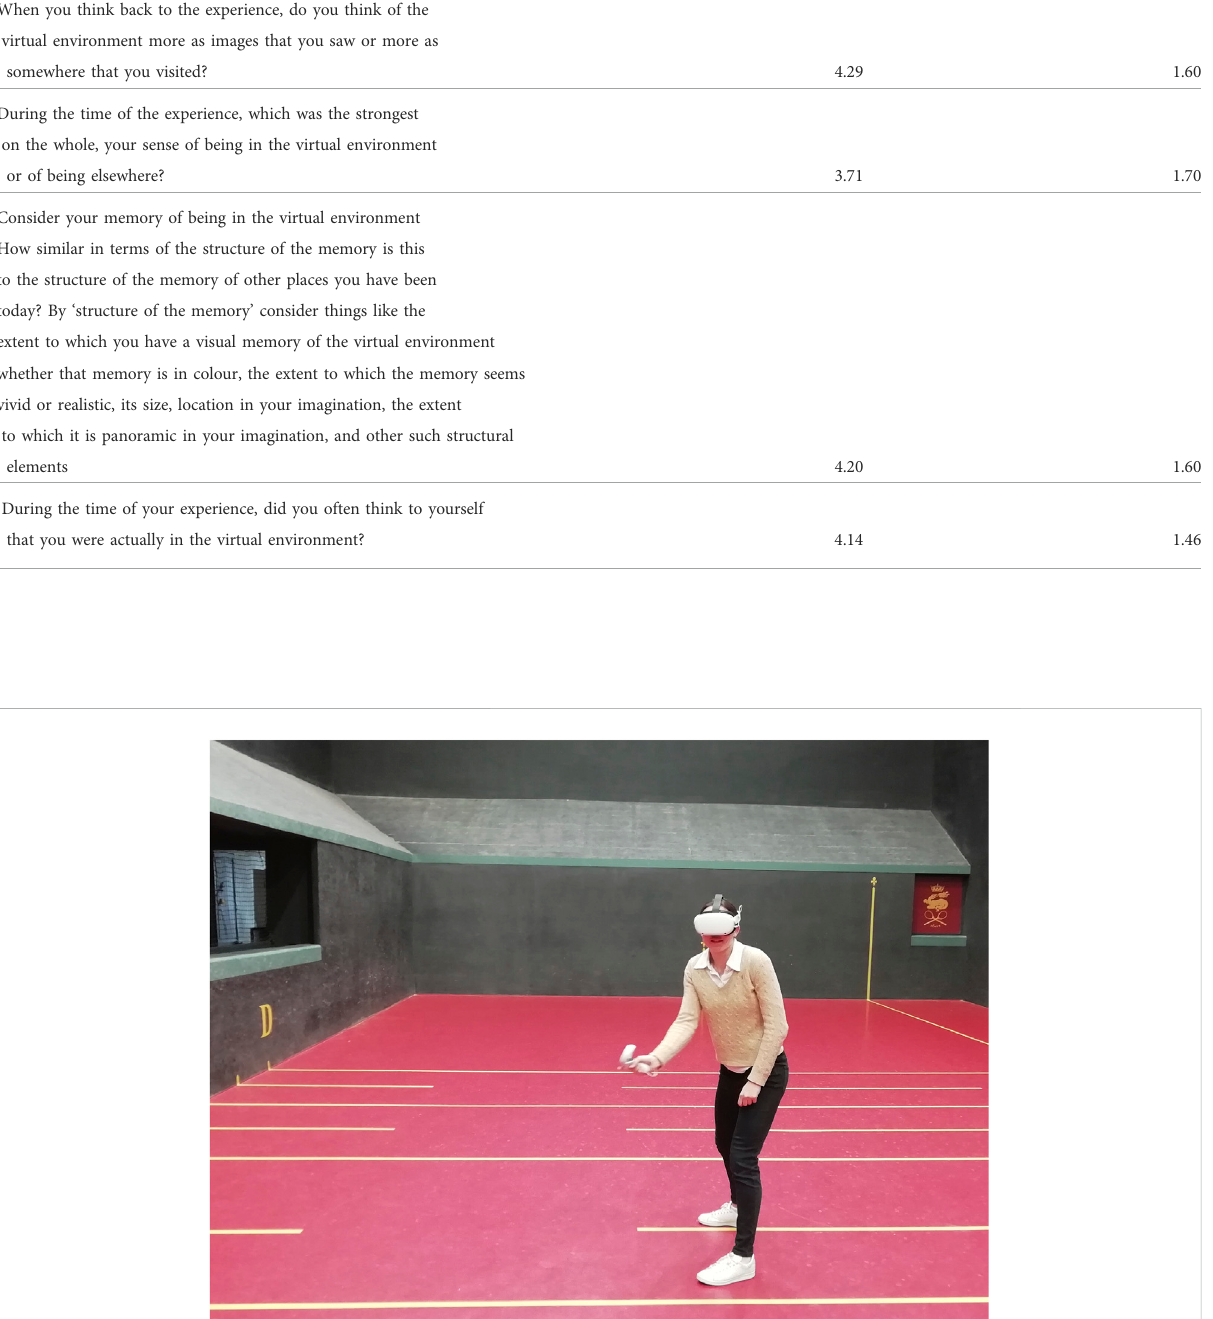
Frontiers in Virtual